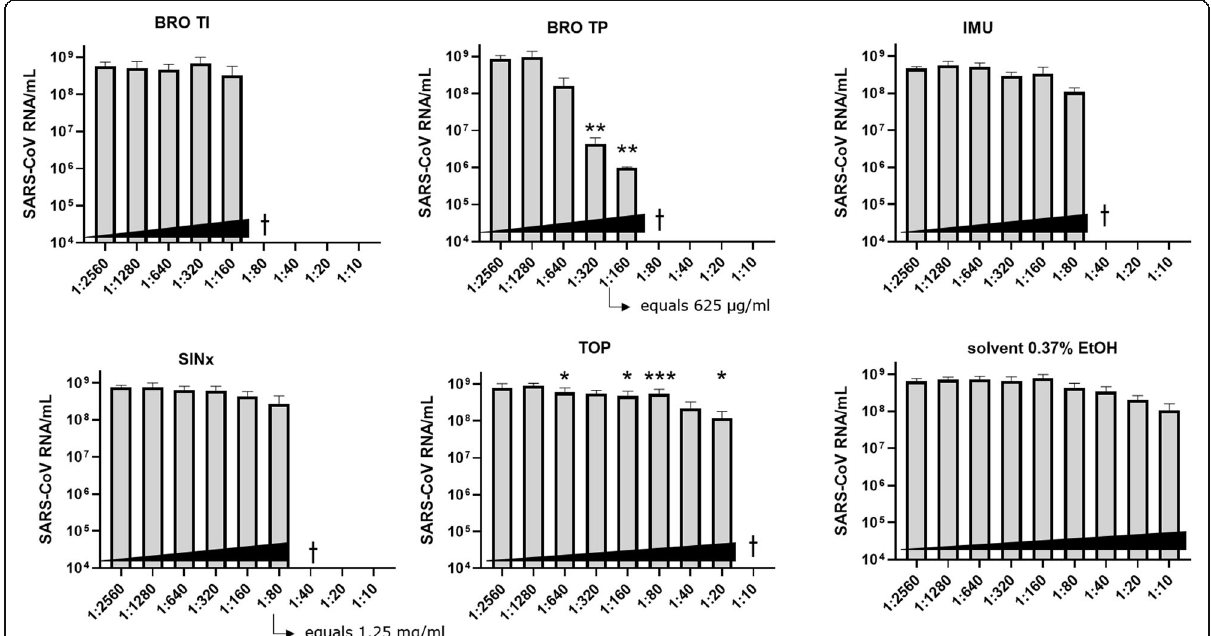
Fig. 1 Reduction of SARS-CoV-2 RNA load by herbal extracts. Vero cells were infected with SARS-CoV-2 (MOI 0.05) and treated with serial twofold dilutions of the indicated herbal extracts or solvent (0.37 % ethanol) for 48 h, followed by determination of viral RNA in the supernatant (qPCR). The means of three independent experiments ± SEM are displayed. The dagger symbol ( † ) indicates concentrations of the extracts ≥ CC 50 . BRO TP and SINx: stock solution was 100 mg/mL, hence concentrations in the assay were 10 mg/mL (dilution 1:10), 5 mg/mL (1:20), 2.5 mg/mL (1:40), 1.25 mg/mL (1:80), 625 µg/mL (1:160), 312.5 µg/mL (1:320), 156.25 µg/mL (1:640), 78 µg/mL (1:1,280) and 39 µg/mL (1:2,560), respectively. Statistics was calculated using log-transformed viral load data in cell culture supernatants, which were compared to 1:2560 using RM one-way